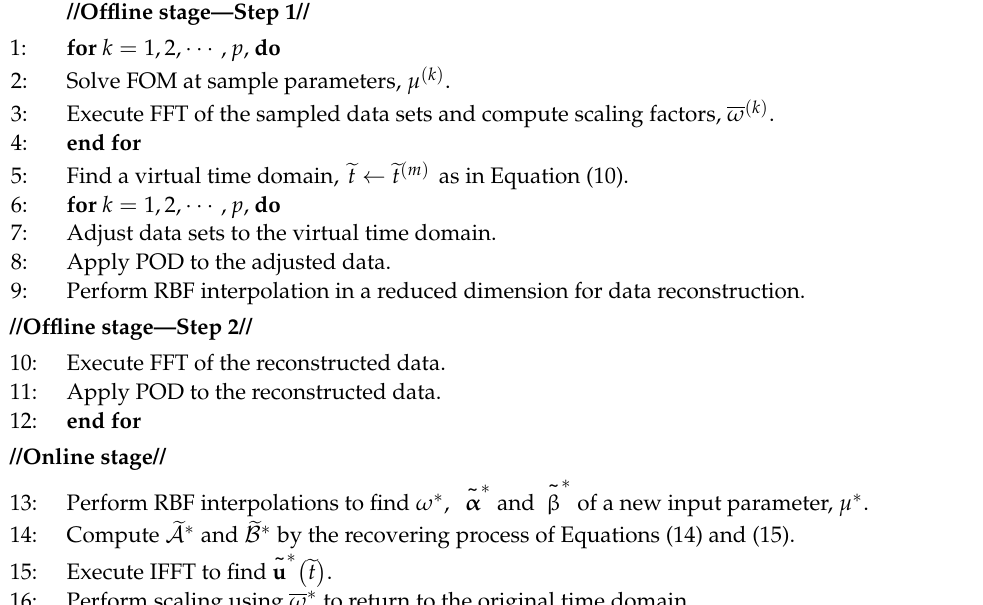
Algorithm 1: Data reconstruction-based two-step non-intrusive